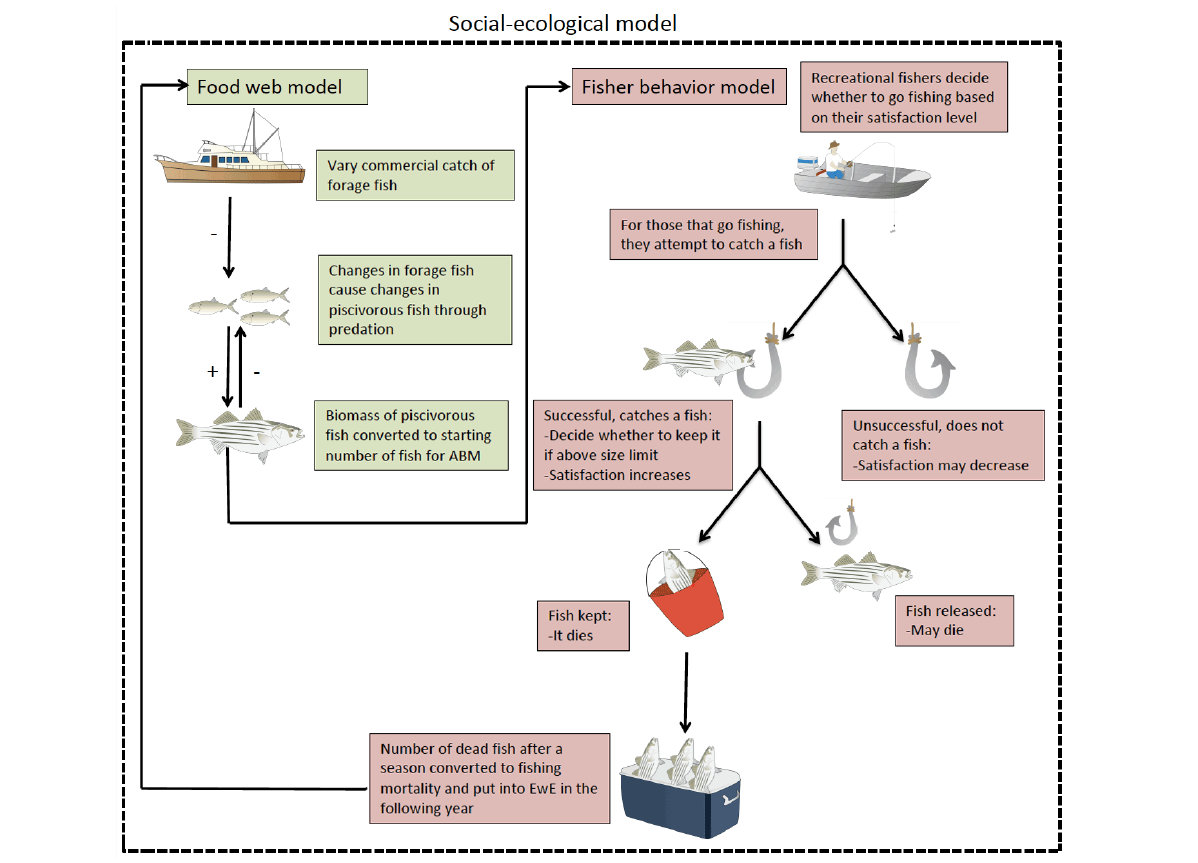
Fig. 1 . Conceptual diagram of our social-ecological model, consisting of the Ecopath with